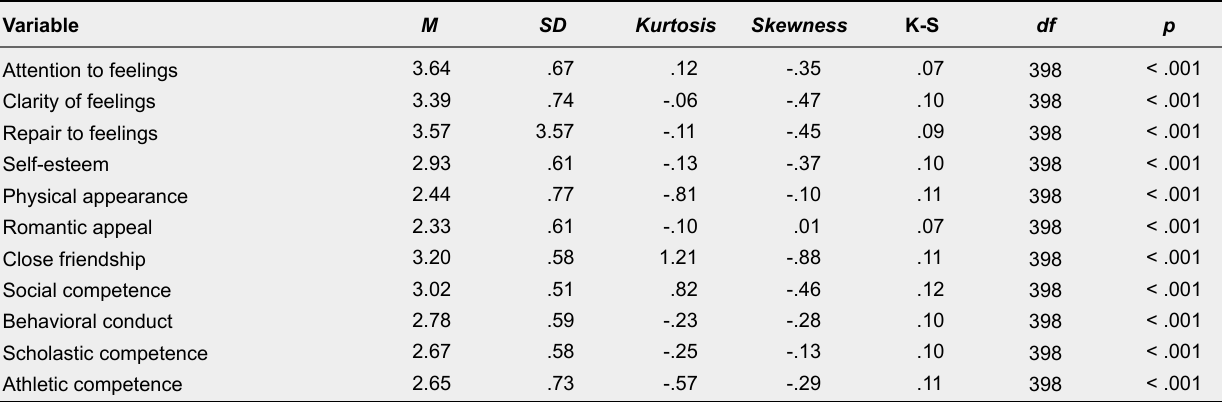
Descriptive Statistics and Kolmogorov-Smirnov Normality Test Variable M SD